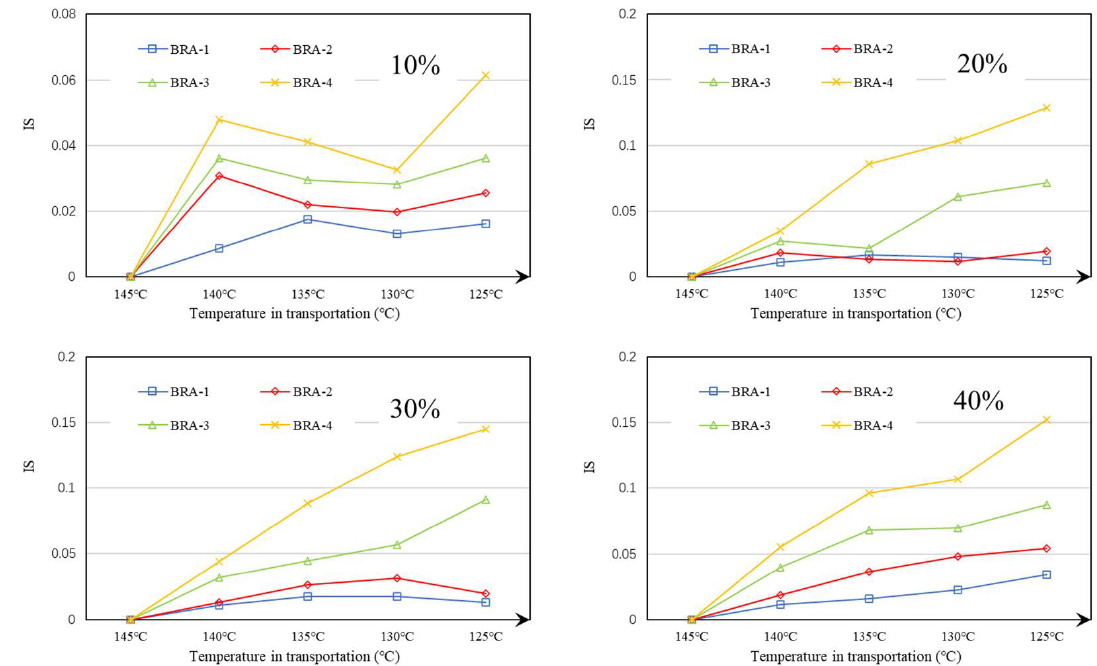
Figure 22. IS of BRA-MA with BRA-1~4 during transportation.